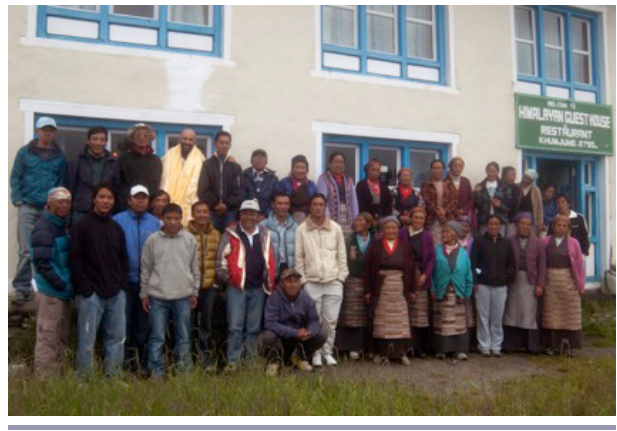
Fig. 3 . Research return presentation attendess in Khumjung/ Khunde settlements within Sagarmatha (Mount Everest) National Park and Buffer Zone. Most pictured were part of a stratified random sample of 100 hourseholds that participated in the research. July 2008. Photo: Passang